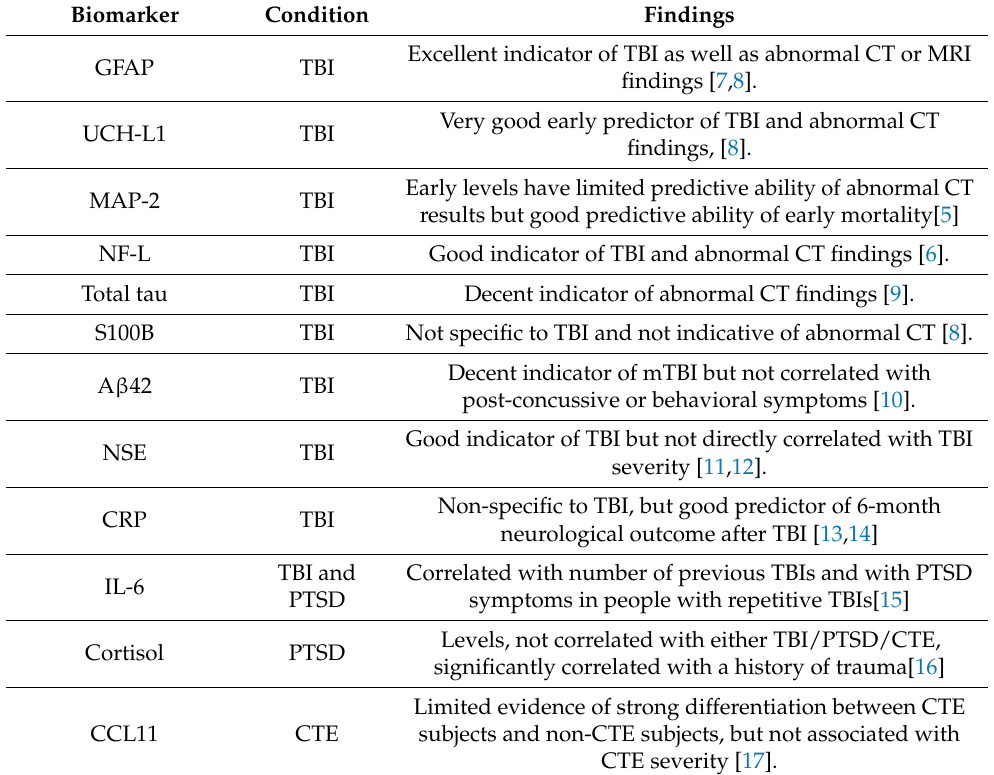
Table 1. Summary of the biomarkers [5–17] present in TBI conditions, PTSD and CTE. Biomarker